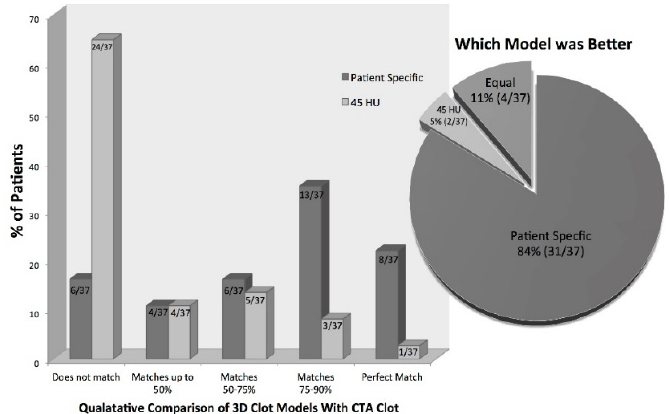
Figure 4. Qualitatively comparing three-dimensional models of the hyperdense thrombus in NCCT with CTA thrombus. Three-dimensional model formed using either (1) calculated patient-specific thresholds or (2) conventional single 45HU threshold.